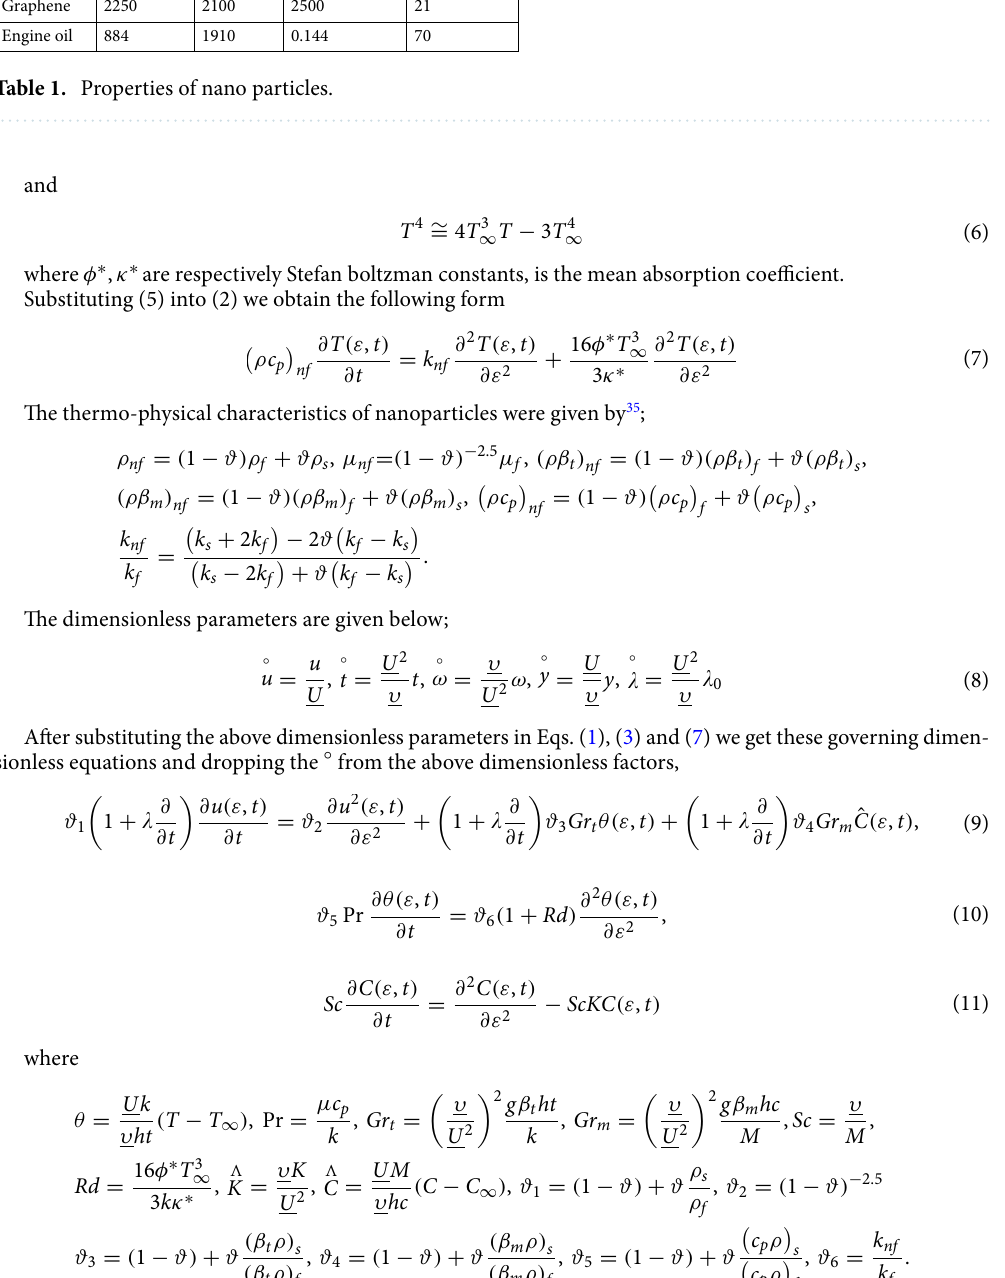
number, Gr m represents mass Grashof number, ϑ denotes volume fraction parameter and Sc represents Schmidt